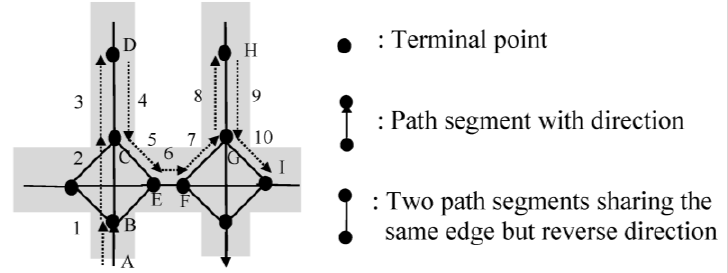
Figure 5. An example for identifying maximal forward